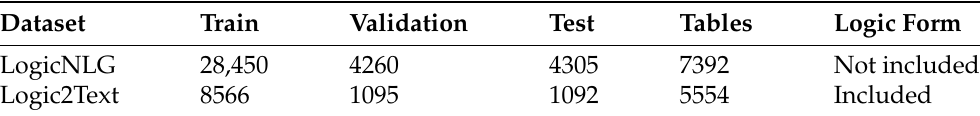
Table 1. Dataset